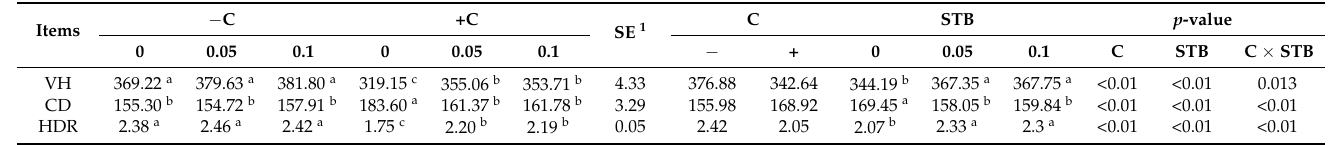
Table 7. Effects of stimbiotic supplementations on the villus height and crypt depth of pigs challenged with STEC.